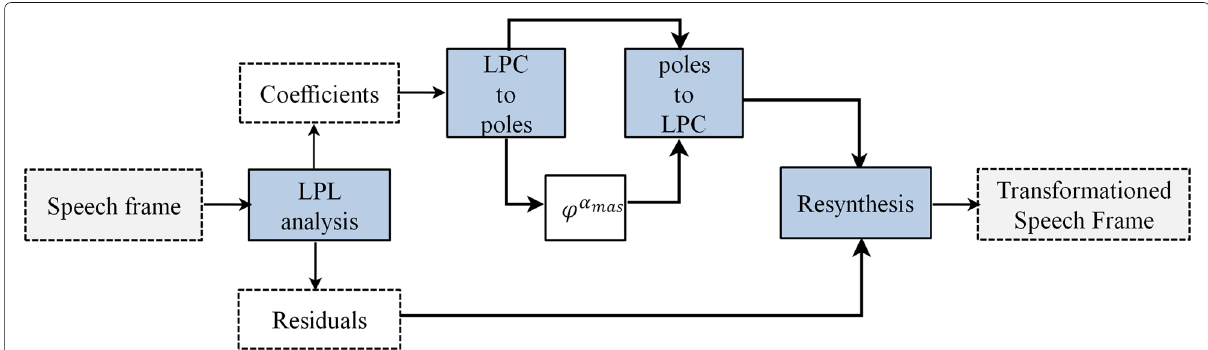
Fig. 3 Pipeline using the McAdams transform method: the pole coordinate coefficients with non-zero imaginary parts are subjected to the power operation of the coefficient α mas , resulting in the distortion of their spectral envelope